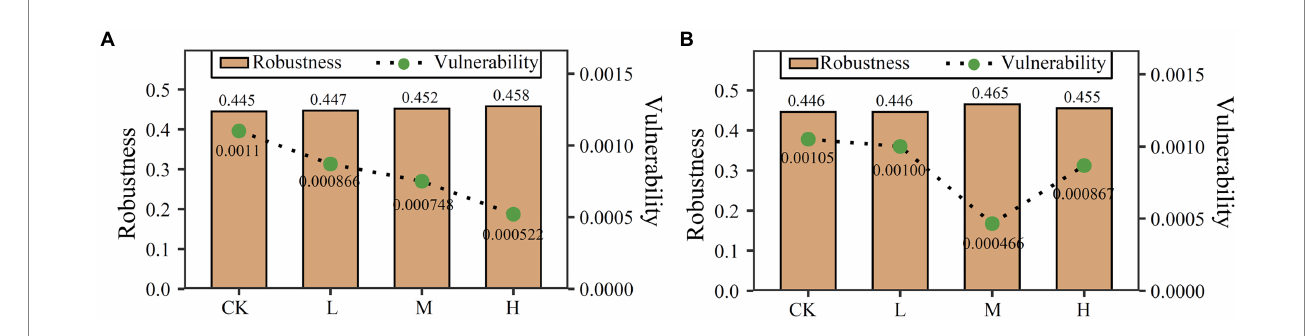
FIGURE 3 Robustness and vulnerability of each network in JSJ (A) and LF (B)